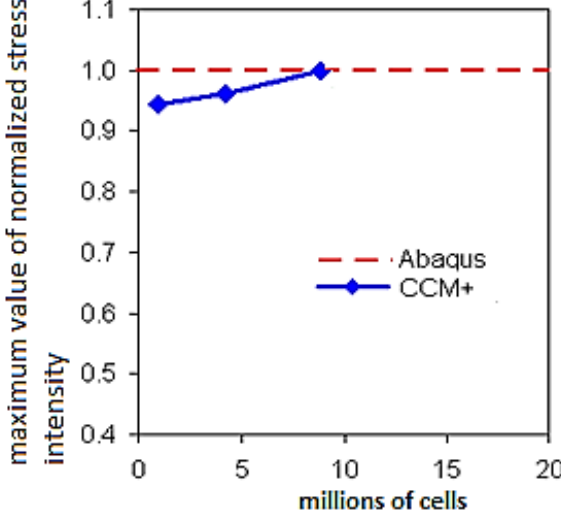
Figure 7: The convergence of the calculation results in STAR-CCM+ during the local mesh